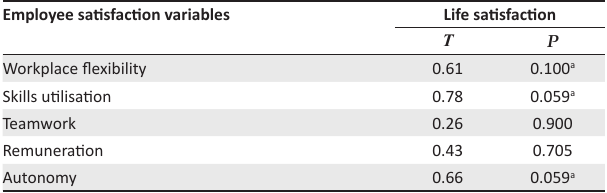
TABLE 3: Kendall’s tau correlation coefficients for association between employee satisfaction and life satisfaction